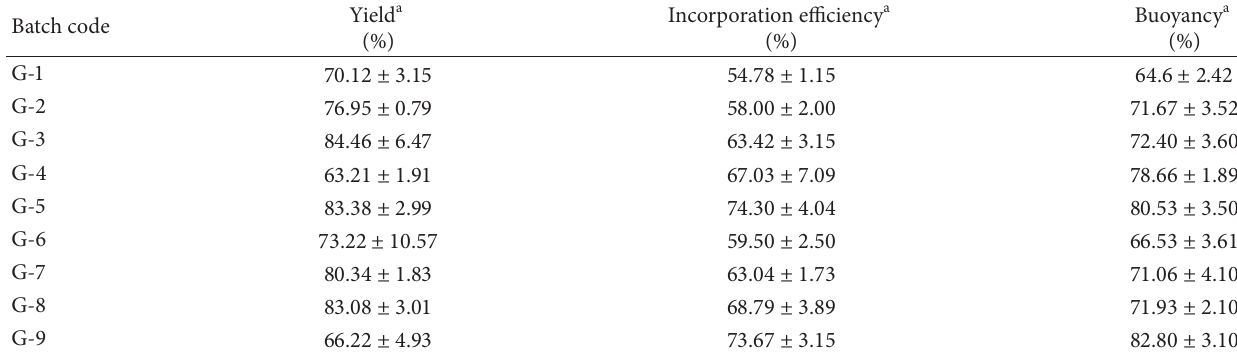
Table 3: Various formulation parameters of floating hollow microspheres.